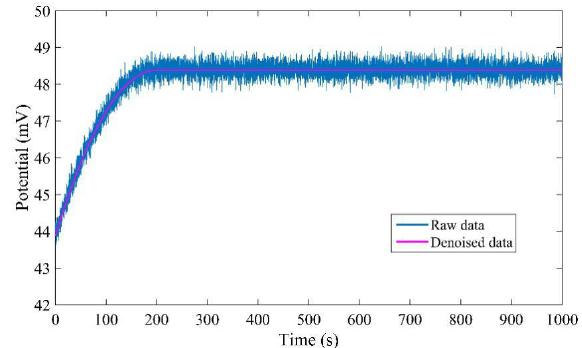
Figure 11. Comparison of raw data and denoised data.